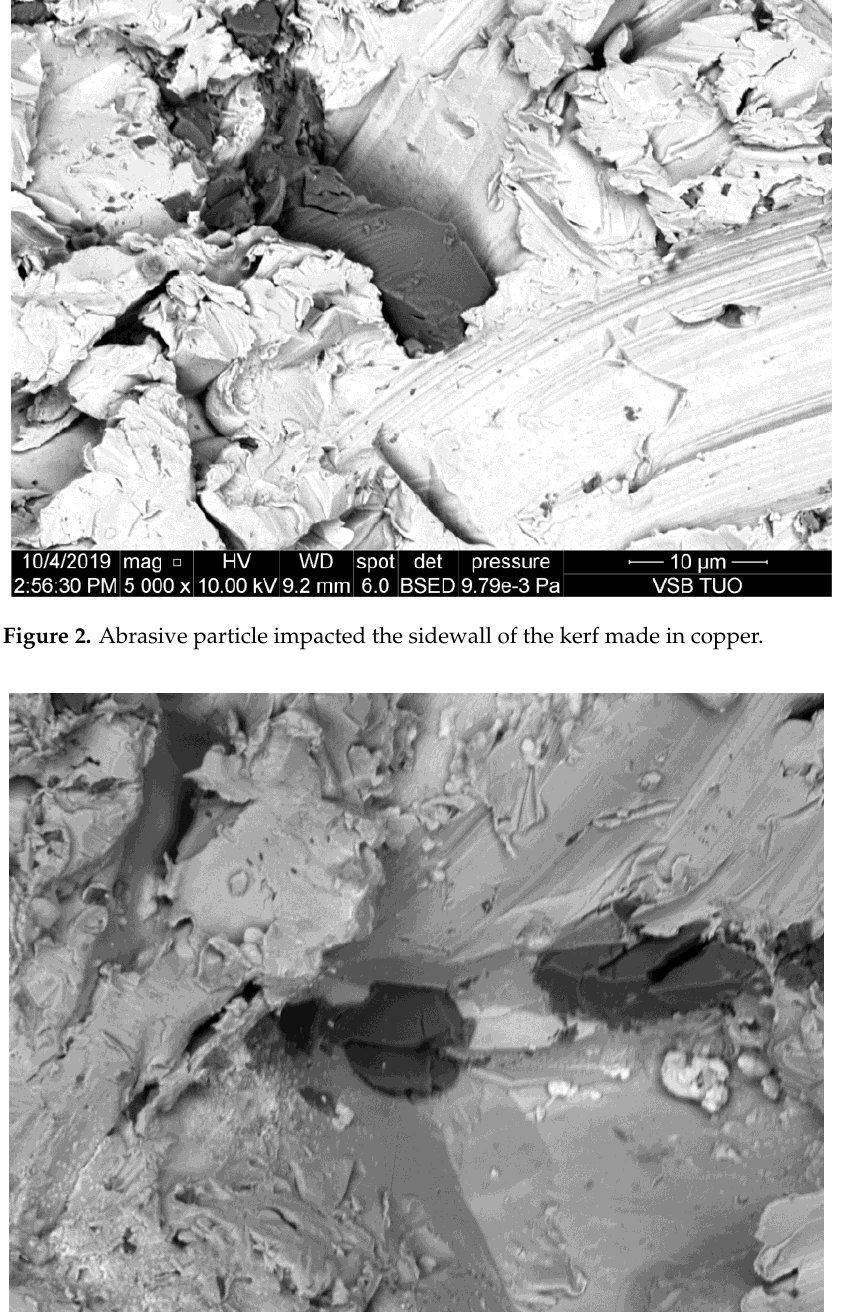
Figure 3. Abrasive particles observed on the sidewall of the kerf made in brass.